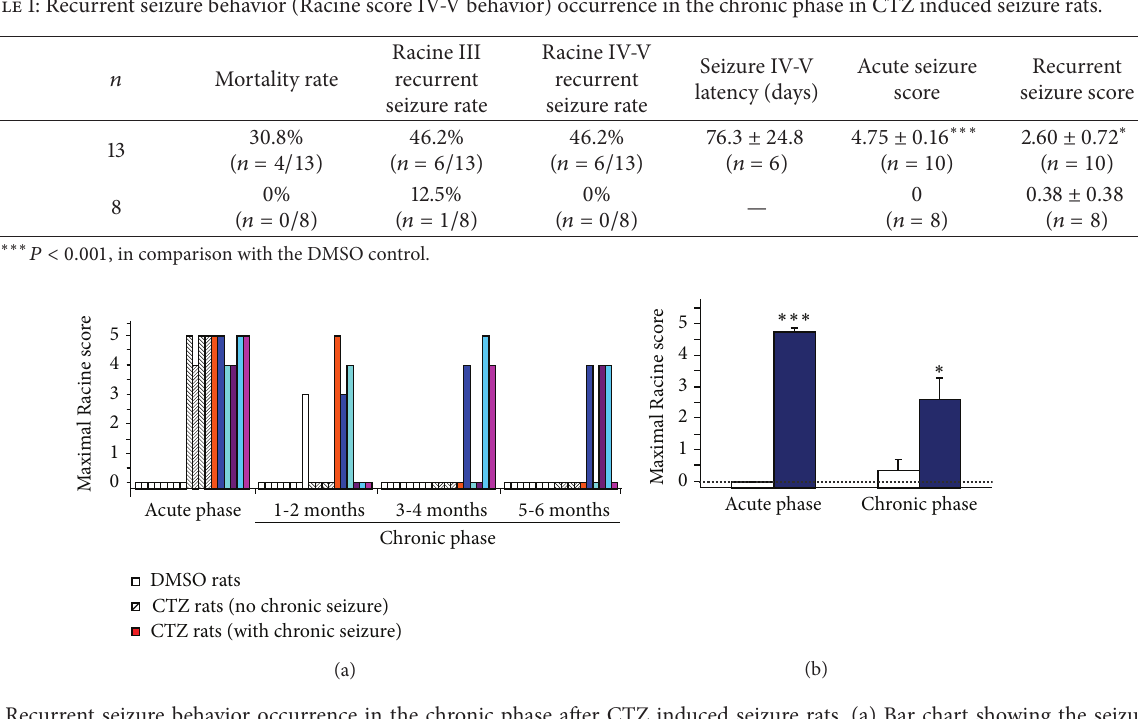
Figure 1: Recurrent seizure behavior occurrence in the chronic phase after CTZ induced seizure rats. (a) Bar chart showing the seizure behavior occurrence within 6-month period after CTZ induced acute seizure in individual rats studied. DMSO control rats ( 𝑛 = 8 ) were represented with white bar and CTZ rats ( 𝑛 = 10 ) were represented with either black strip bars ( 𝑛 = 4 ) or color bars ( 𝑛 = 6 ) for rats without or with recurrent seizure observed, respectively. (b) Bar chart showing the group maximal seizure scores obtained from the DMSO control rats ( 𝑛 = 8 ) and CTZ rats ( 𝑛 = 10 ) recorded for 6 months after CTZ induction of the seizure ( ∗ 𝑃 < 0.05 , ∗∗∗ 𝑃 < 0.001 , in comparison with the DMSO